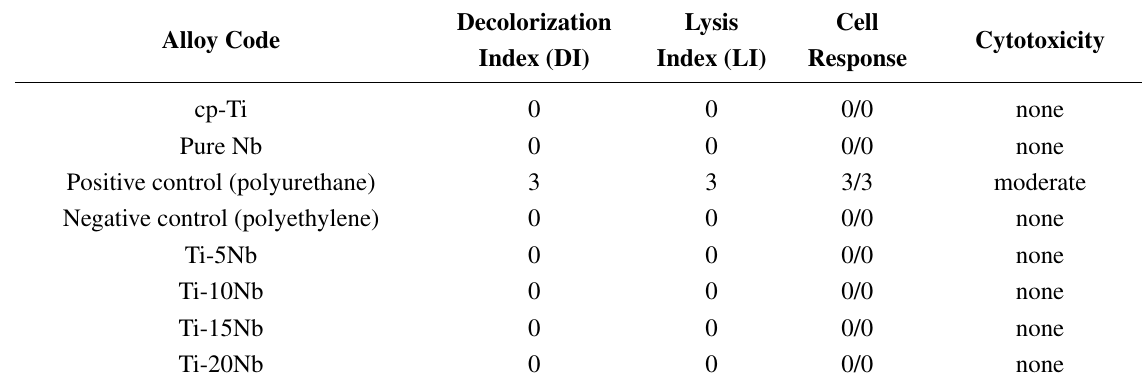
Table 4. Cytotoxicity of pure metal and Ti-xNb alloys based on the agar overlay test ( n =